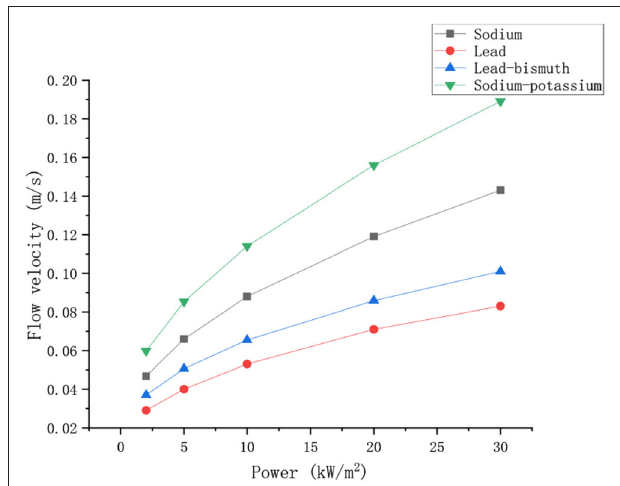
FIGURE 6 | Effect of heating power on velocity of different liquid